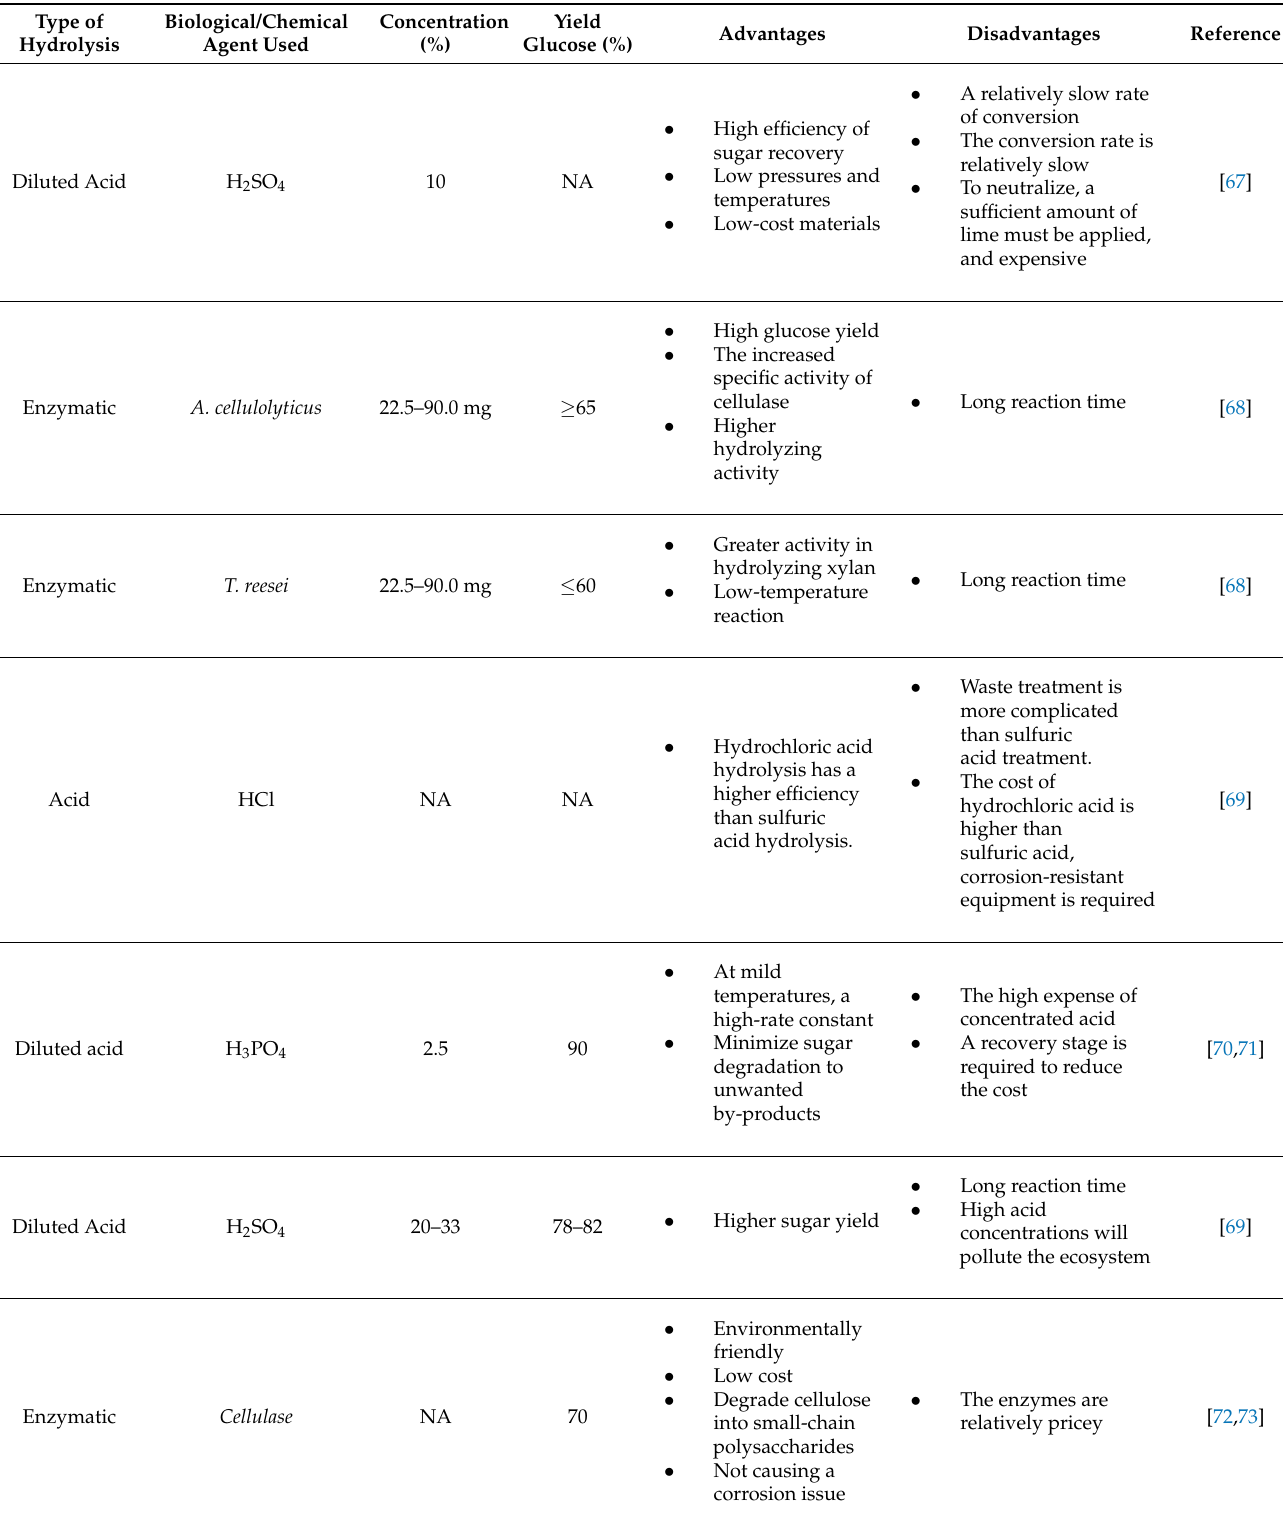
Table 2. The advantages and disadvantages of various types of